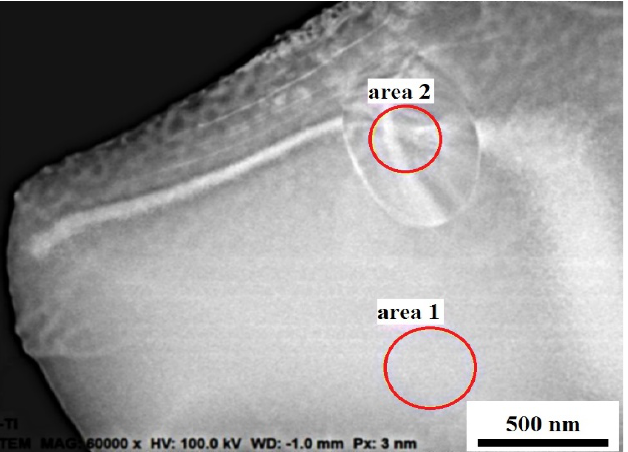
Figure 4. Image of a section of a deformed titanium nickelide sample obtained by scanning trans- mission electron microscopy.